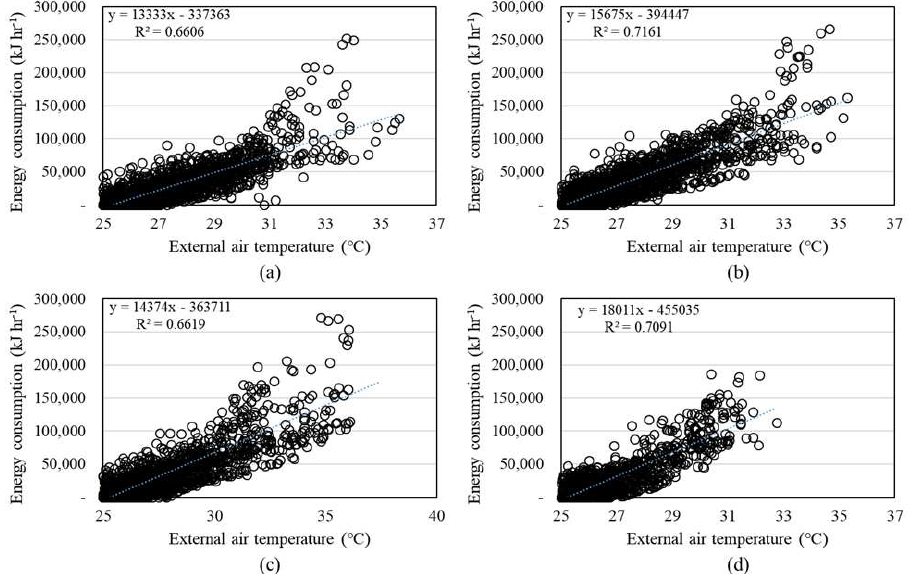
Figure 20. Changes in the cooling energy load of BiRTG by region and according to external air temperature in ( a ) Seoul, ( b ) Daejeon, ( c ) Daegu, and ( d ) Pusan.